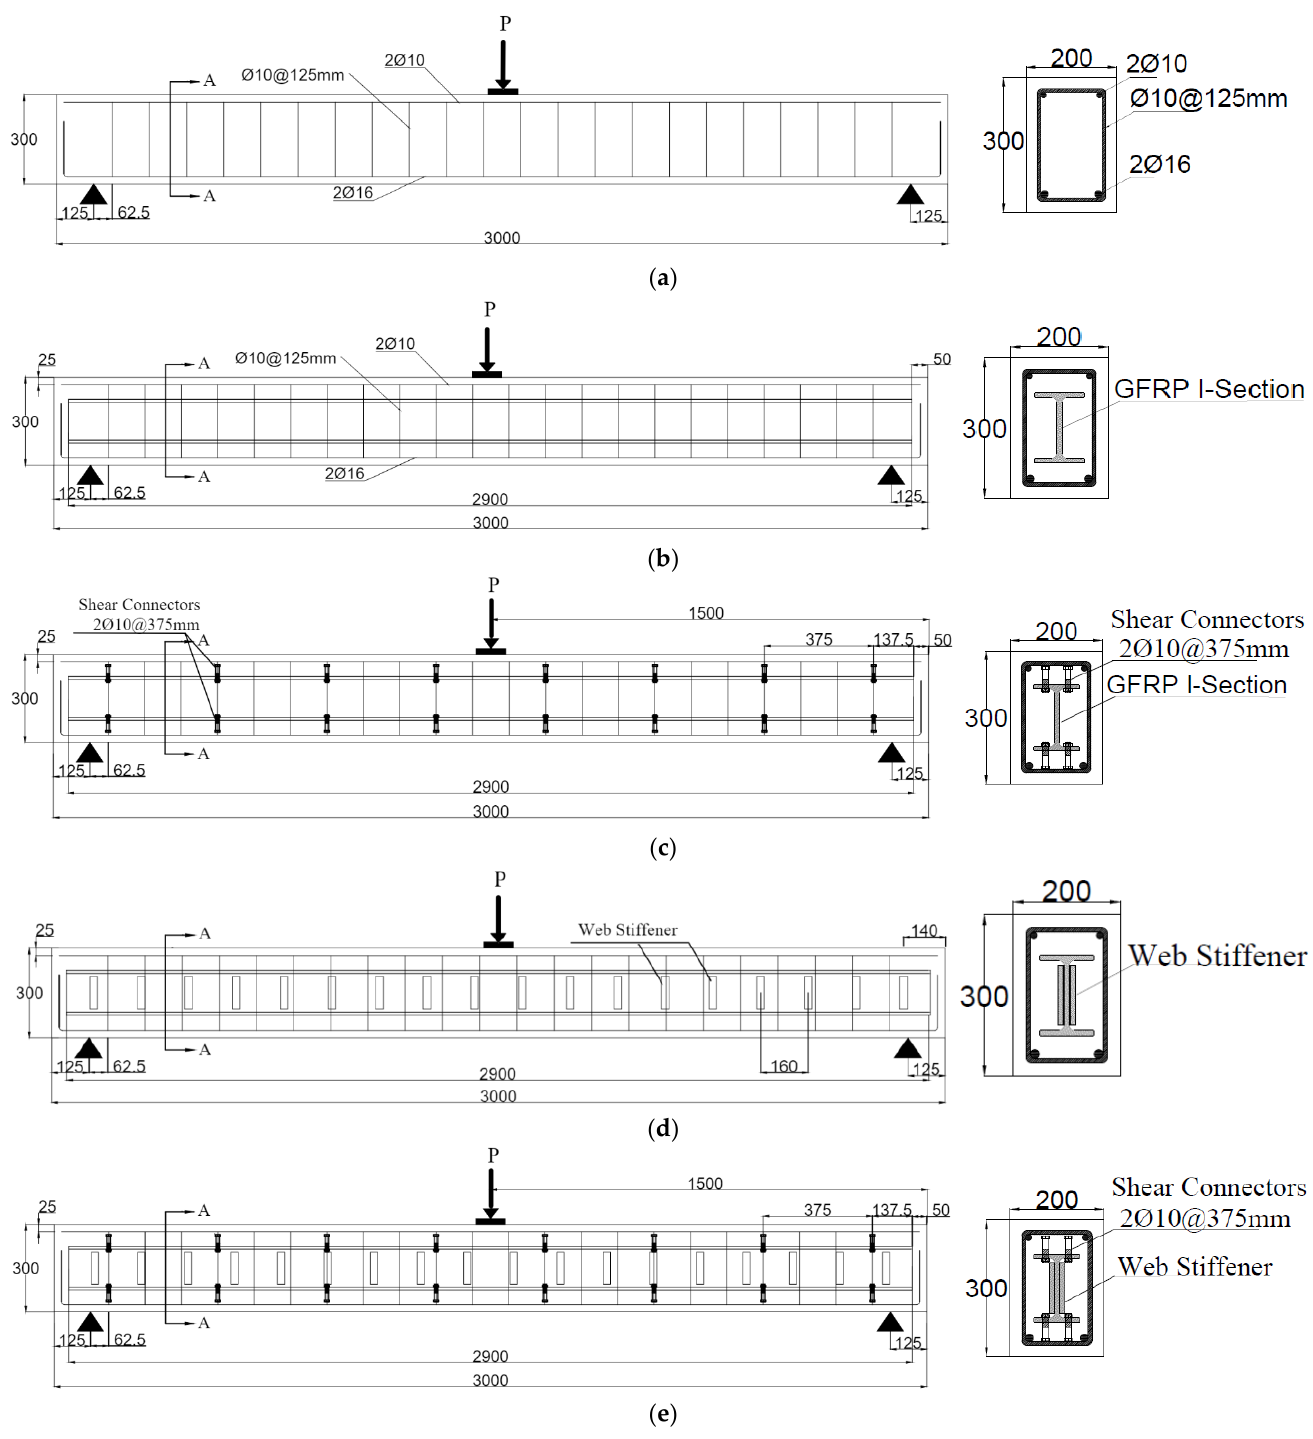
Figure 1. Details of the tested specimens. (All dimensions are in mm). ( a ) Ref beam. ( b ) EG beam. ( c ) EGS beam. ( d ) EGW beam. ( e ) EGSW beam.